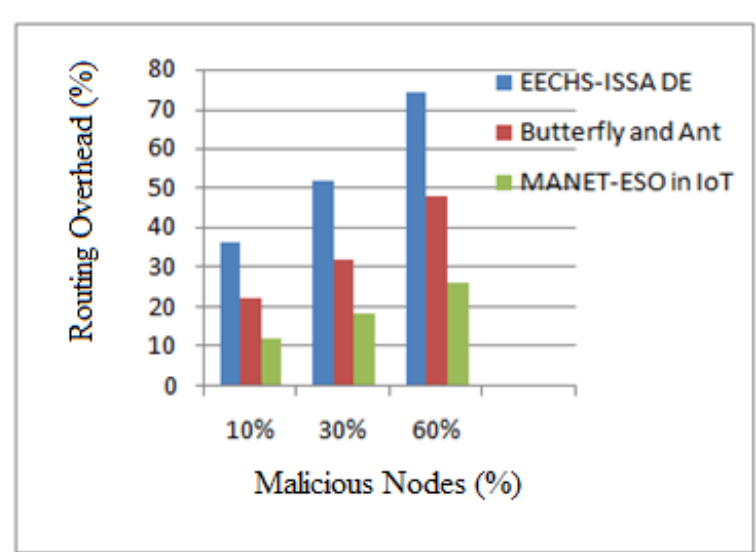
Figure 8. Routing Overhead vs. Malicious Nodes (%).